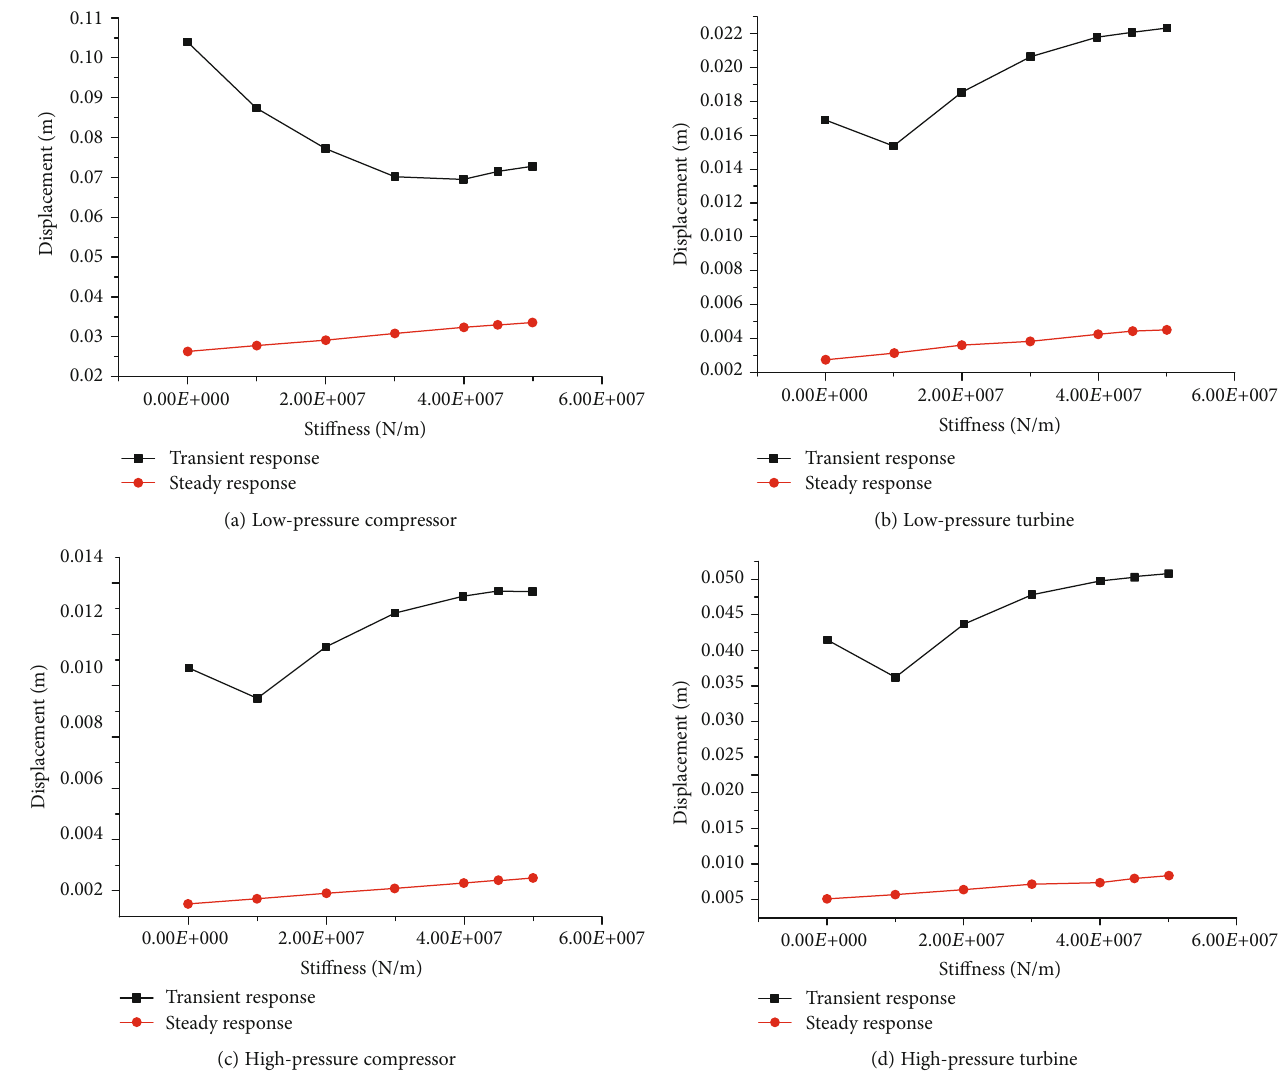
Figure 17: Displacement change with reduction in residual sti ff ness of bearing